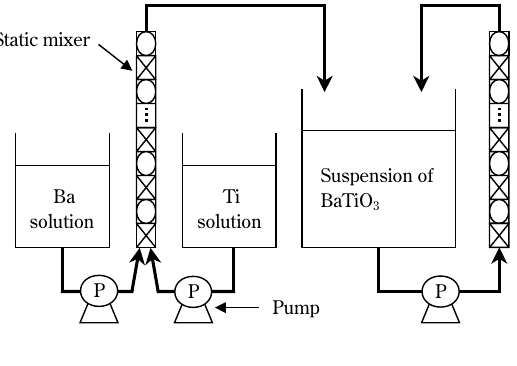
Schematic diagram of a synthesis